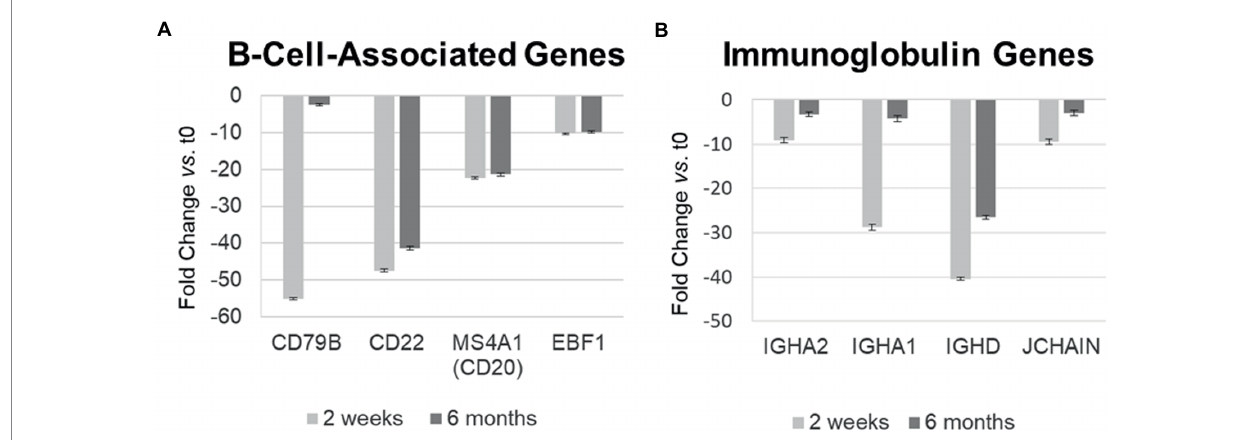
FIGURE 4 Differential gene expression over time in individual B-cell-related genes in MS PBMC at 2 weeks and 6 months after ocrelizumab infusion compared time 0. (A) B-cell-associated genes typically remain decreased at 2 weeks and 6 months after anti-CD20 infusion. All values are significantly below 0; CD22 and CD20 show biologically slight, but statistically significant recovery between 2 weeks and 6 months after infusion; p < 0.05 or less, two-tailed paired t -test. (B) Immunoglobulin-associated gene expression returns toward baseline at 6 months. All values are significantly below 0 and show statistically significant recovery between 2 weeks and 6 months. Fold-change at 2 weeks (light gray) and 6 months (dark gray). IGHA, IgA heavy chain; JCHAIN, Joining chain of multimeric IgA and IgM; other genes described in text. Bars show mean ± SEM.